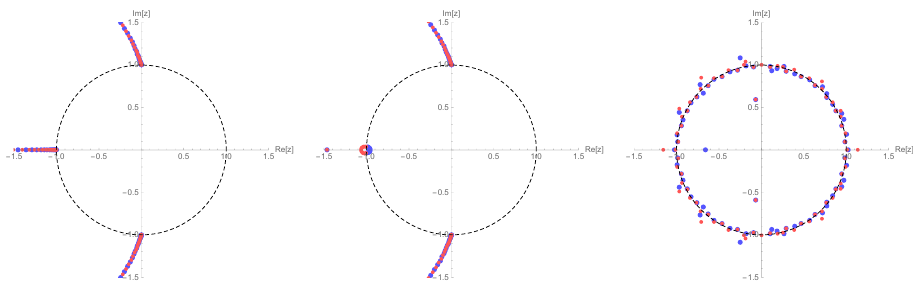
Figure A3. Padé approximants tell us singularity structures of complex functions. We show the distribution of zeros (light blue) and poles (light red) for F [ 80/80 ] ( z ) ( left ), G [ 80/80 ] ( z ) ( middle ) and H [ 80/80 ] ( z ) ( right ). The black dashed line is the convergence